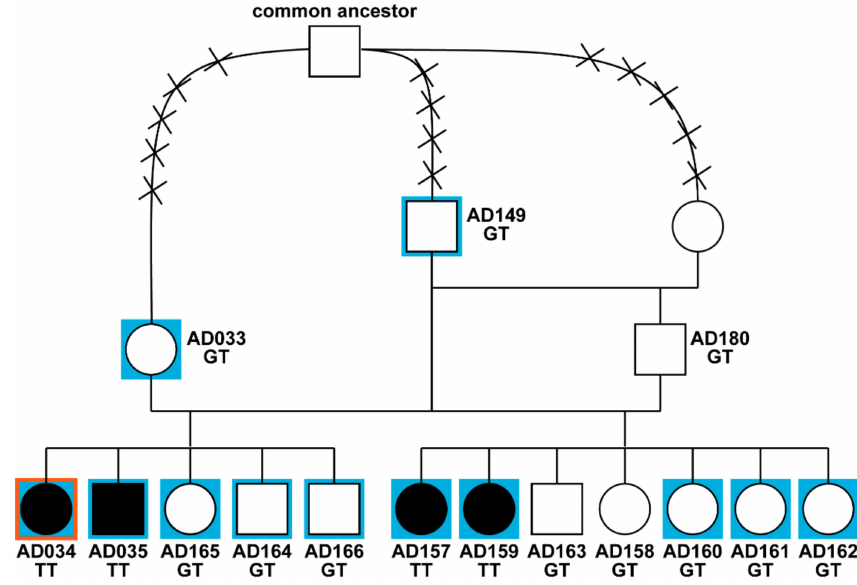
Figure 1. Pedigree of Alpine Dachsbracke dogs used for genetic mapping of spinocerebellar ataxia. Filled symbols represent spinocerebellar ataxia-a ff ected dogs. The blue background indicates animals, which were genotyped on the single nucleotide variant (SNV) array, and the red contour indicates an a ff ected dog selected for whole-genome resequencing. A common ancestor in both maternal and paternal lineages was identified. The crosses intersecting the connection lines represent the number of generations to the common ancestor. Note that the male ‘AD149’ sired the first litter and is also the grandsire of the second litter produced by his son